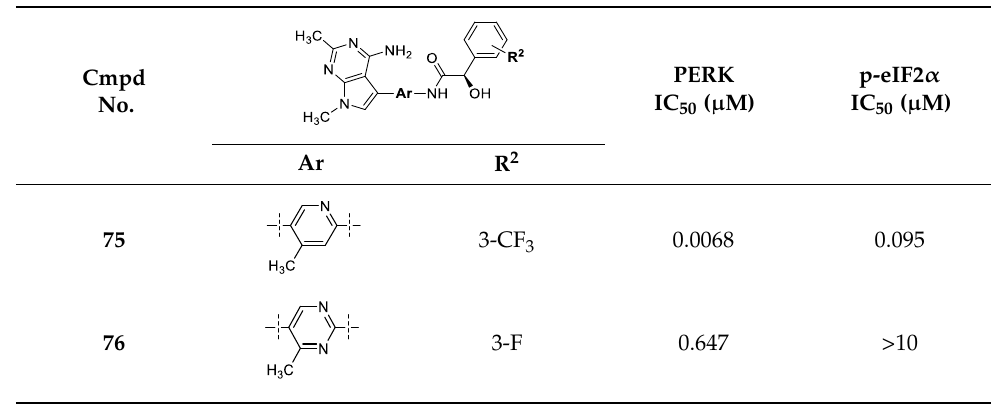
Table 3. In vitro data of PERK inhibitors with proximal and terminal ring modifications. Table 3. Cont .